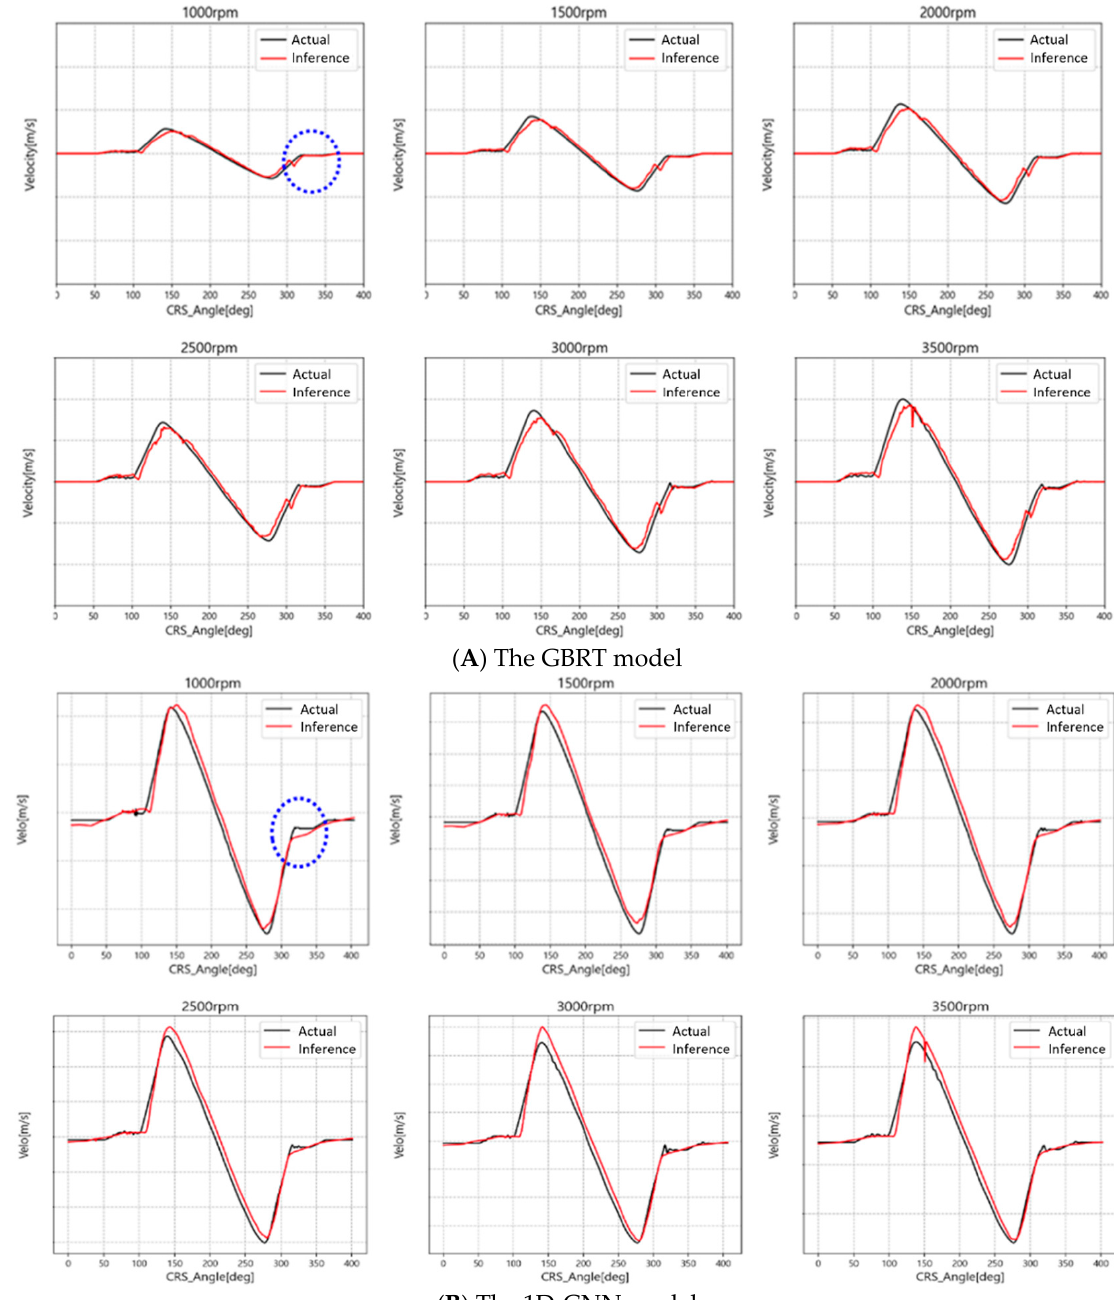
Figure A3. Comparing the actual and predicted values of the valve seating velocity by crank angle reference RPM using the GBRT and 1D-CNN models.